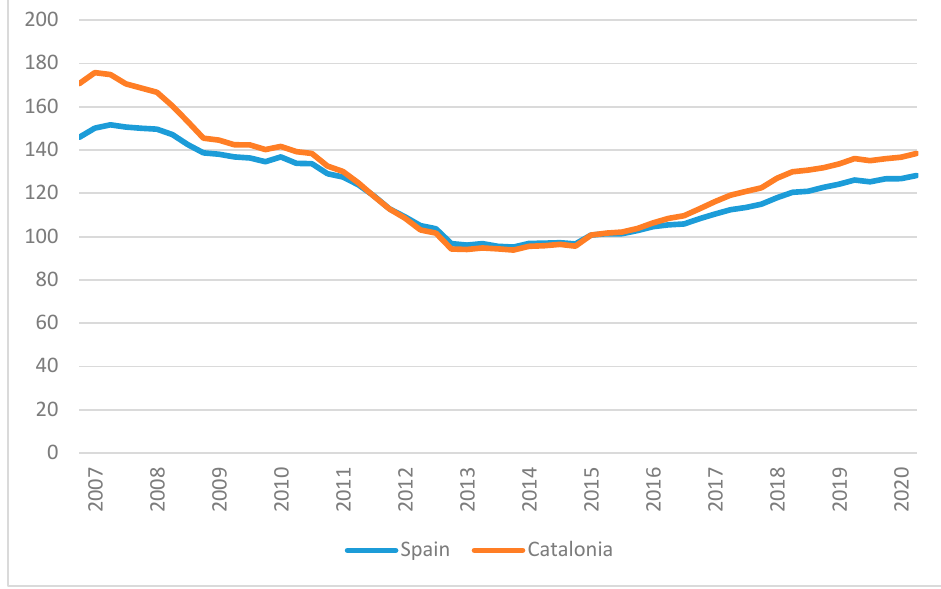
Figure 2. Housing Price Index (2007–2020). Source: Instituto Nacional de Estadística (INE) [71].